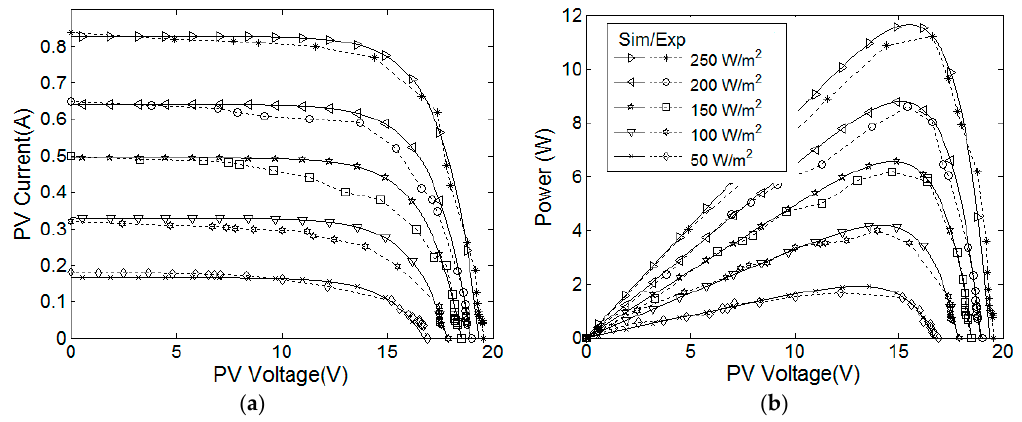
Figure 8. Experimental ( a ) I - V and ( b ) P - V characteristics at different irradiances of halogen bulb.